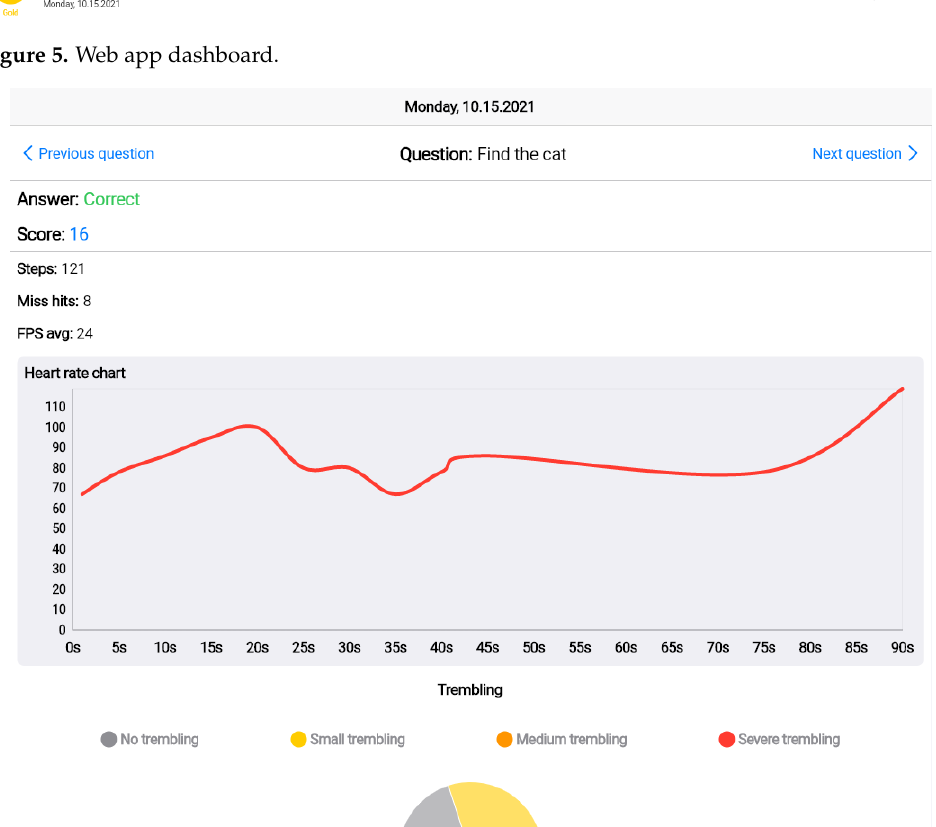
Figure 6. Score and heart rate